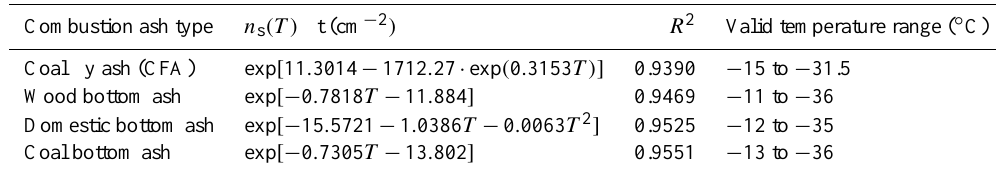
Figure 7. Ice nucleation active sites ( n s ) distribution for CFA, wood bottom ash, domestic bottom ash, and coal bottom ash particles, obtained from freezing experiments in µL- and nL-NIPI. Each panel represents the cumulative number of nucleation active sites ( n s ) on the ash particles calculated from the ice nucleation singular model and it covers all the temperature range explored during the freezing experiments. For the µL-NIPI experiments, n-pipette represents normal pipette and lr-pipette is for low retention pipette – all experiments shown in this figure were performed with the n -pipette (1.00 ± 0.025µL) except where indicated. On the wood bottom ash panel, the experiments indicating 23 and 40 ◦ C were performed to test the effect of the initial temperature of the suspensions on its freezing ability. The equations for the n s parameterizations and their valid temperatures for each of the combustion ashes are shown in Table 3. Estimated error bars are only shown for a selection of data sets for clarity and in many of these cases the error bars are smaller than the size of the data points. Table 3. n s parameterizations for combustion ash samples investigated in this report. The temperature ( ◦ C) ranges for which the fits are valid are shown for each of the ash